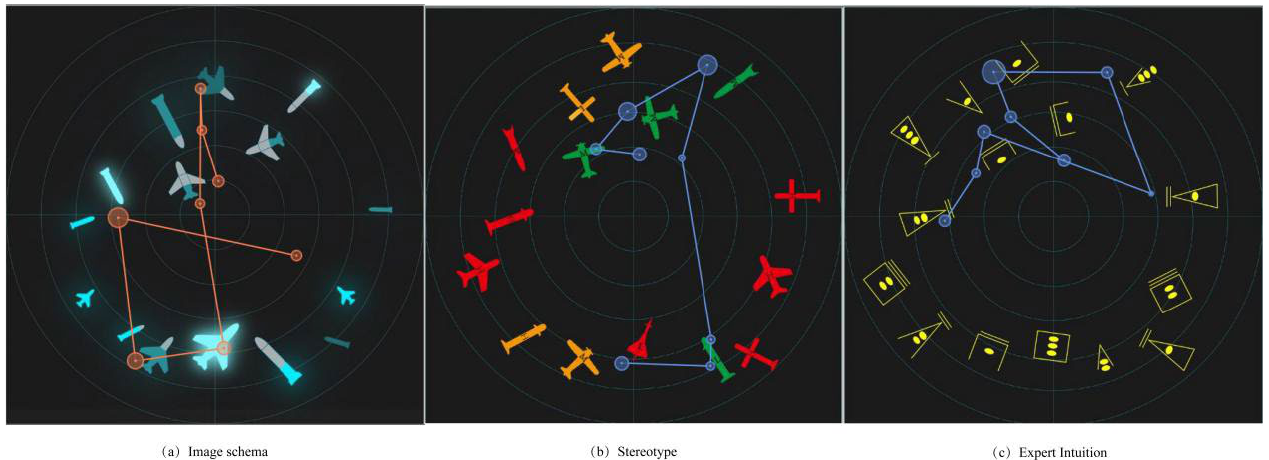
Figure 7. Sweeping path